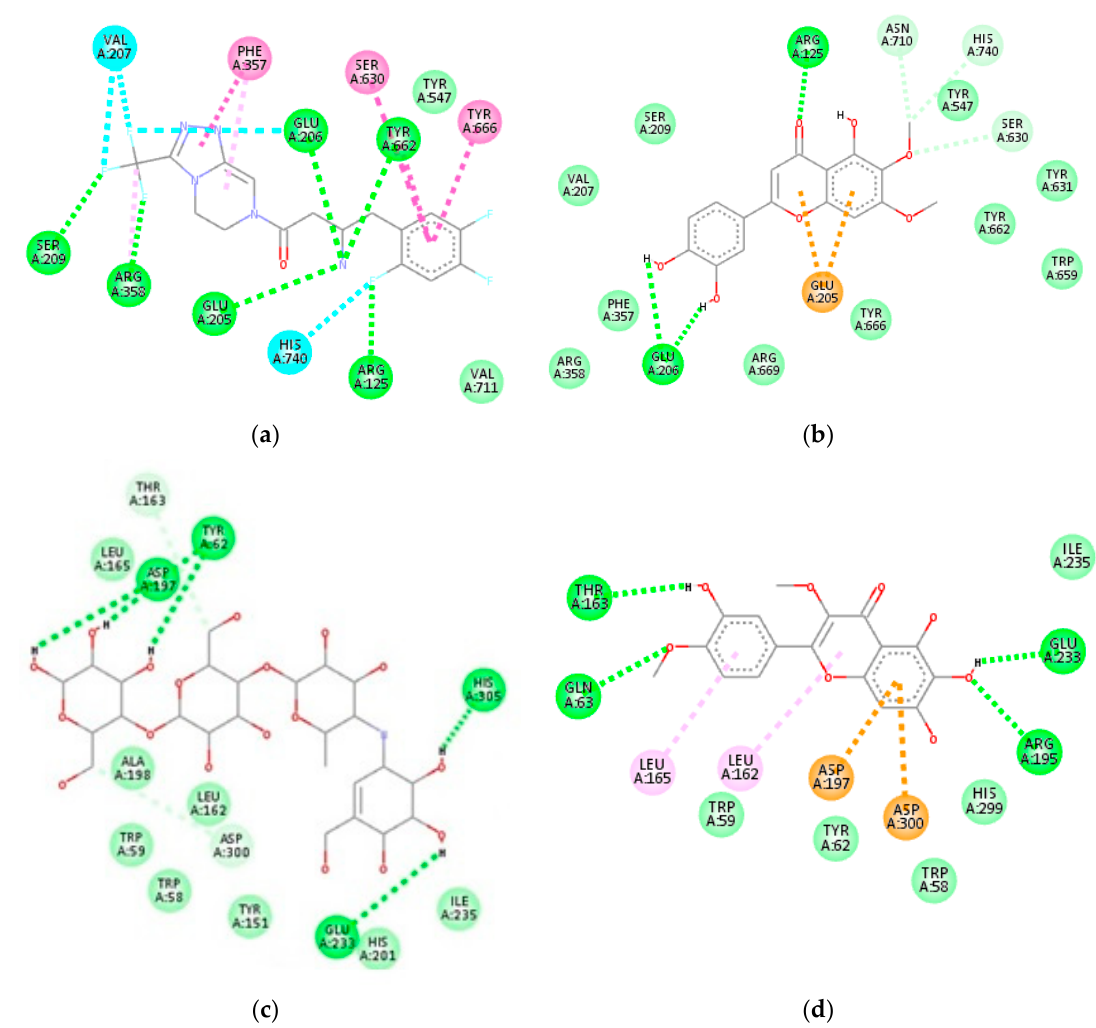
Figure 3. Two-dimensional interaction diagram of compounds with amino acid residues of DPP-4 and α -amylase enzymes: ( a ) sitagliptin and DPP-4, ( b ) 5,3 ′ ,4 ′ -trihydroxy-6,7-dimethoxy-flavone and DPP-4, ( c ) acarbose and α -amylase, ( d ) quercetagetin-3,4 ′ -dimethyl ether and α -amylase. Table 4. Binding affinity and interacting residues of the identified compounds with DPP-4 and α - amylase enzyme.